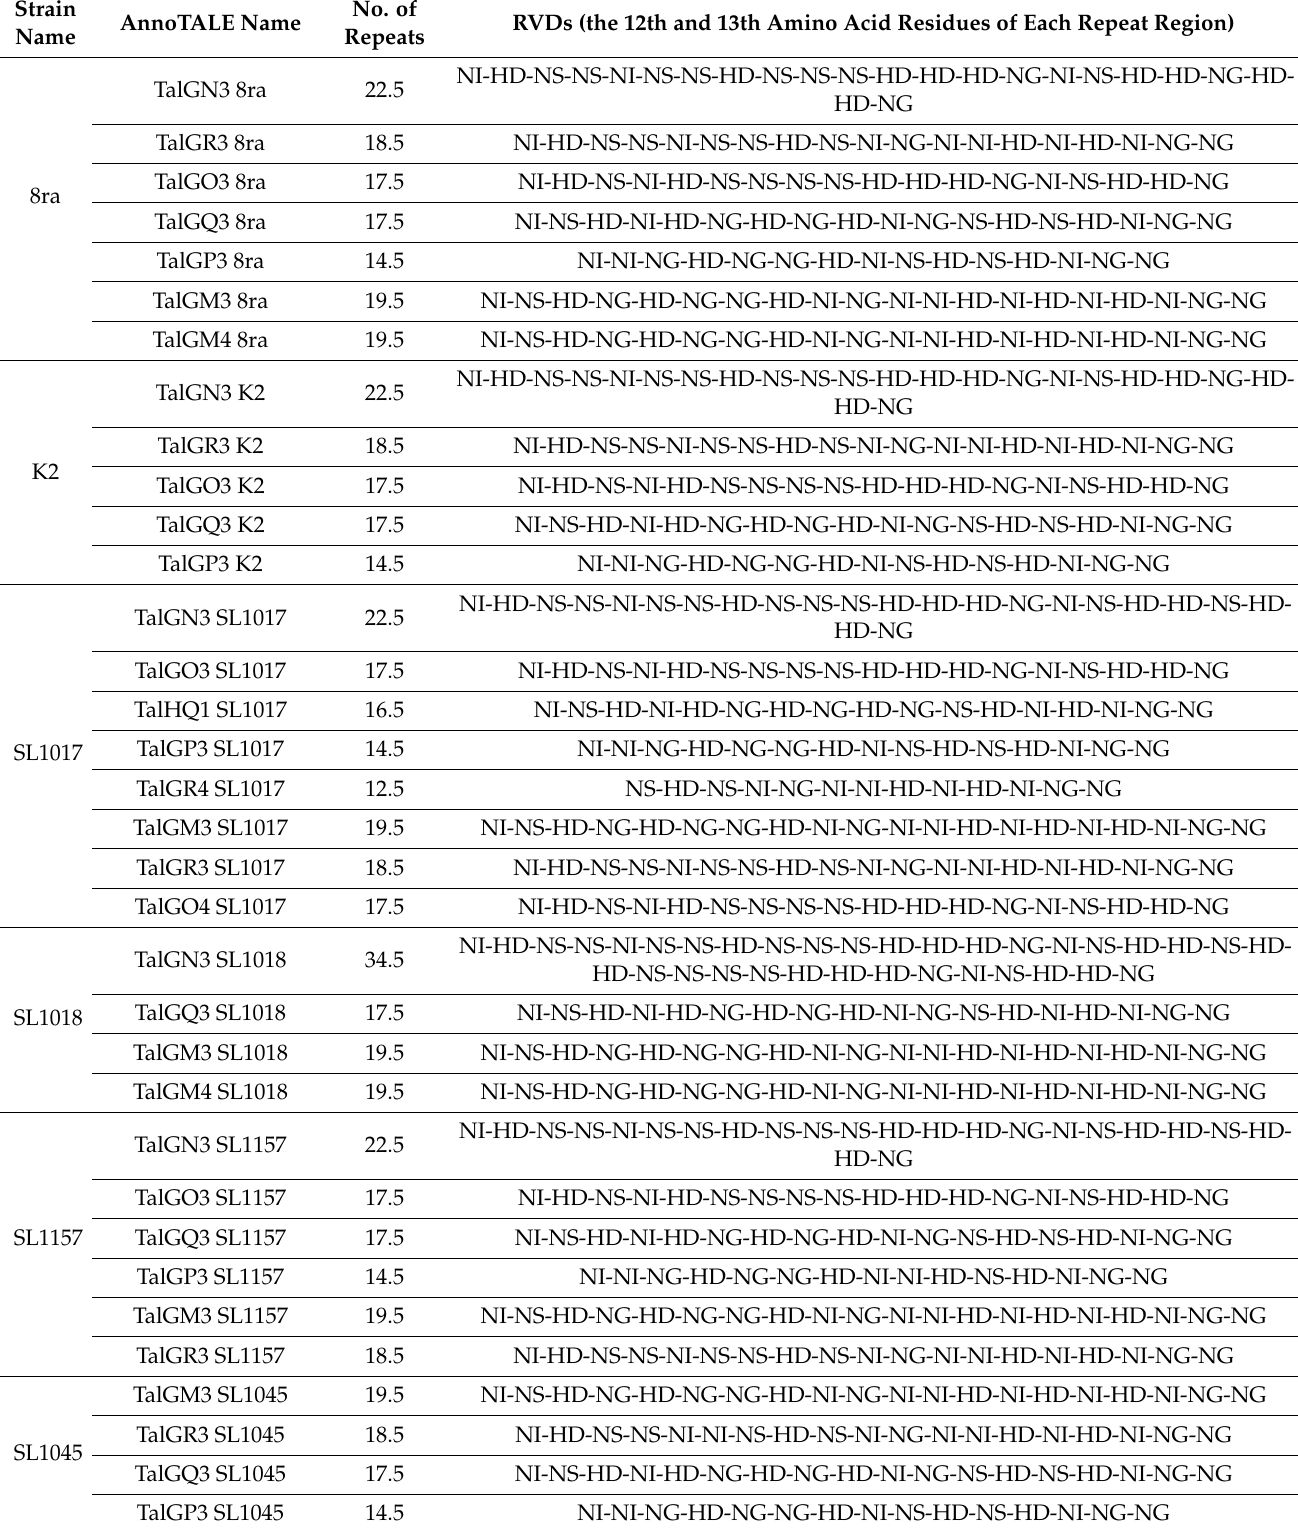
Table 2. The transcription activator-like effectors (TALEs) that were identified in six Xcg strains and annotated using AnnoTALE based on the repeat variable di-residues